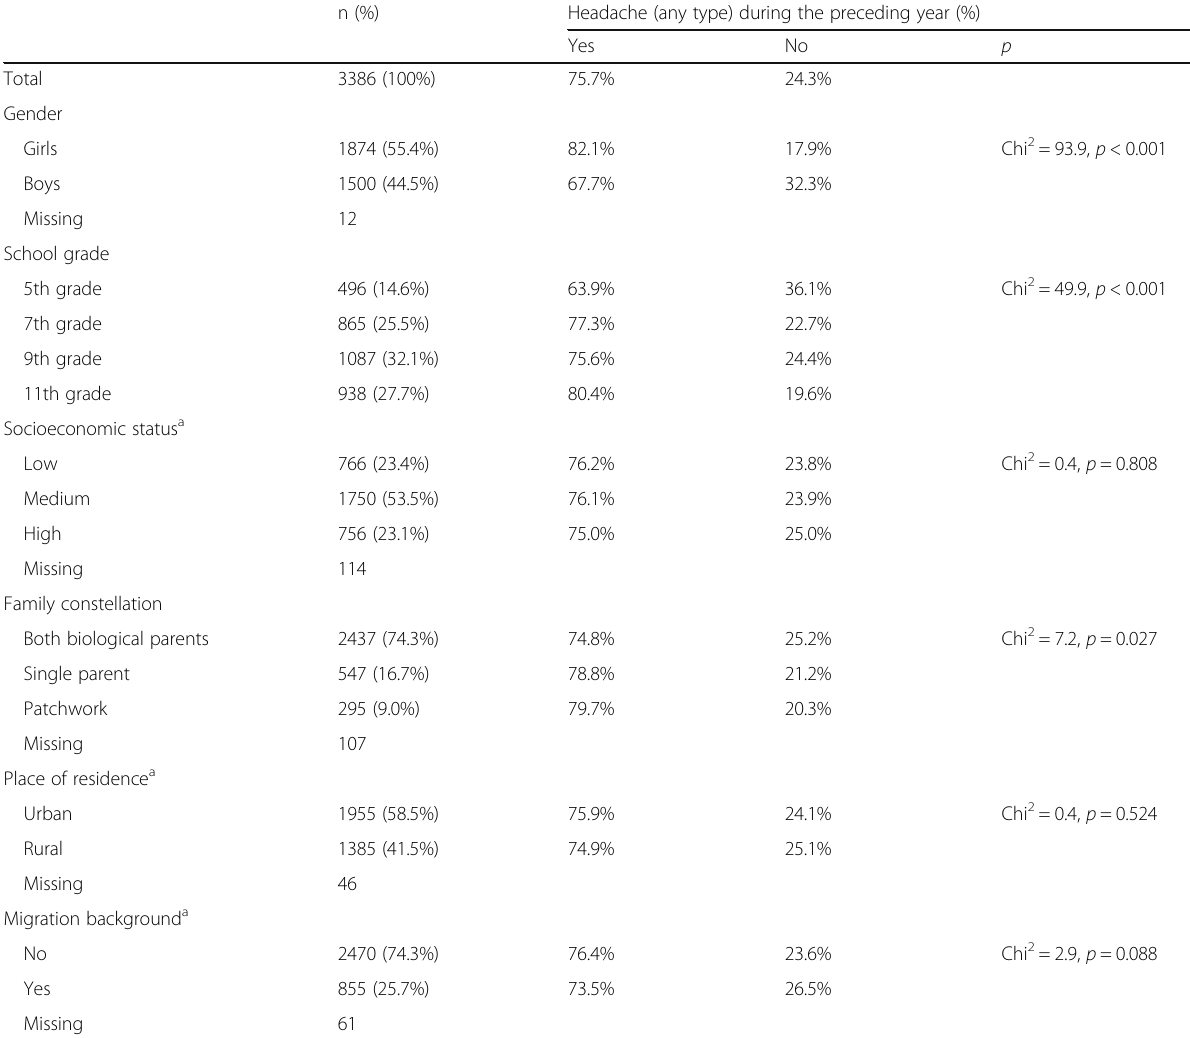
Table 1 Headache prevalence by sociodemographic characteristics in the sample n (%) Headache (any type) during the preceding year